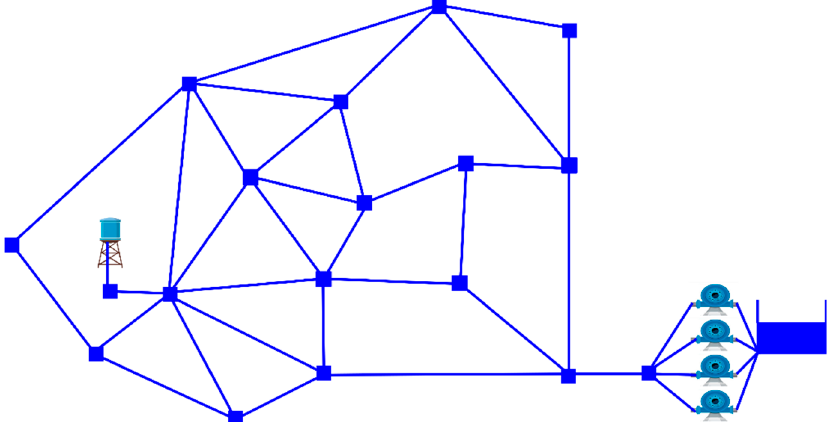
Figure 4. Anytown network. Figure 4. Anytown